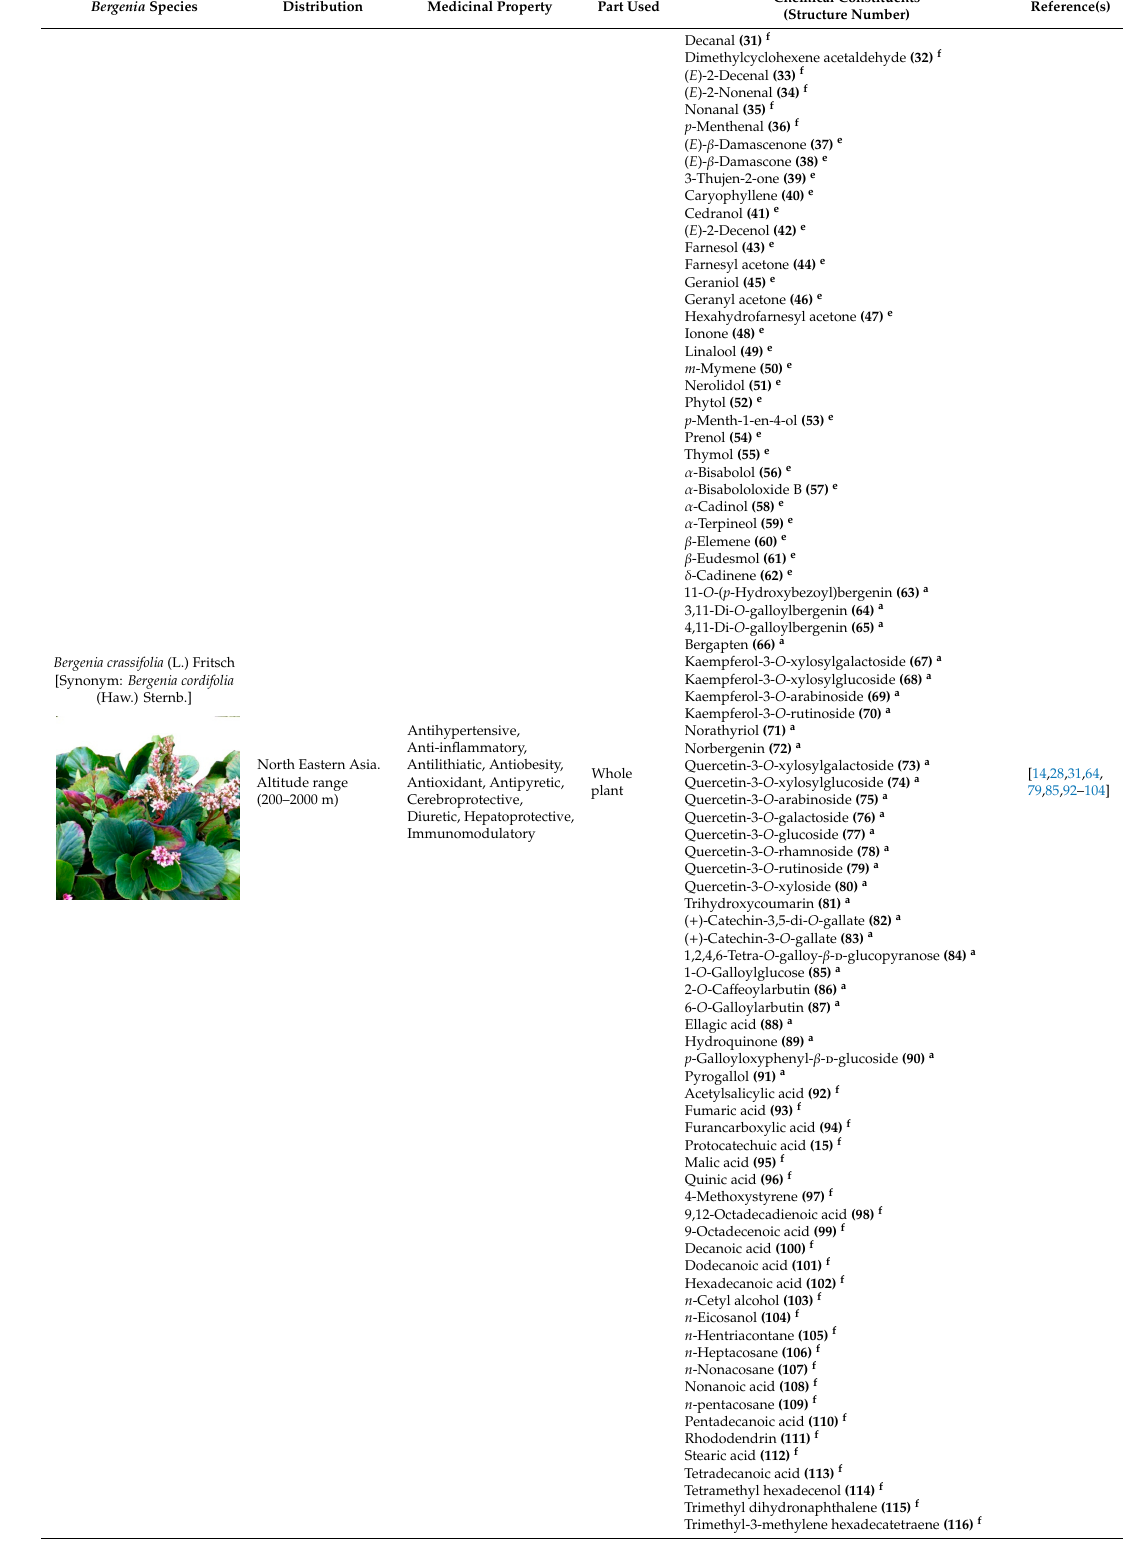
Bergenia crassifolia (L.) Fritsch Bergeniacrassifolia (L.)Fritsch [Synonym: Bergenia cordifolia [Synonym: Bergeniacordifolia (Haw.) (Haw.) Sternb.]